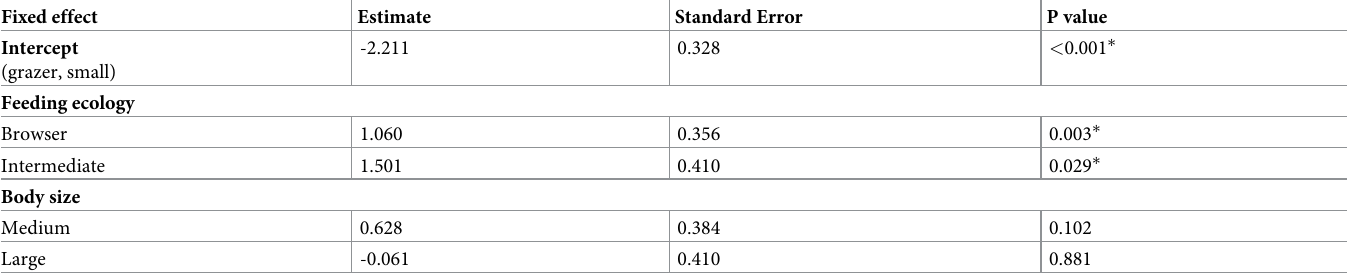
Table 8. Coefficients and P values for the negative binomial GLMM investigating the influence of habitat type, feeding ecology, and body size on the amount of time spent vigilant in the